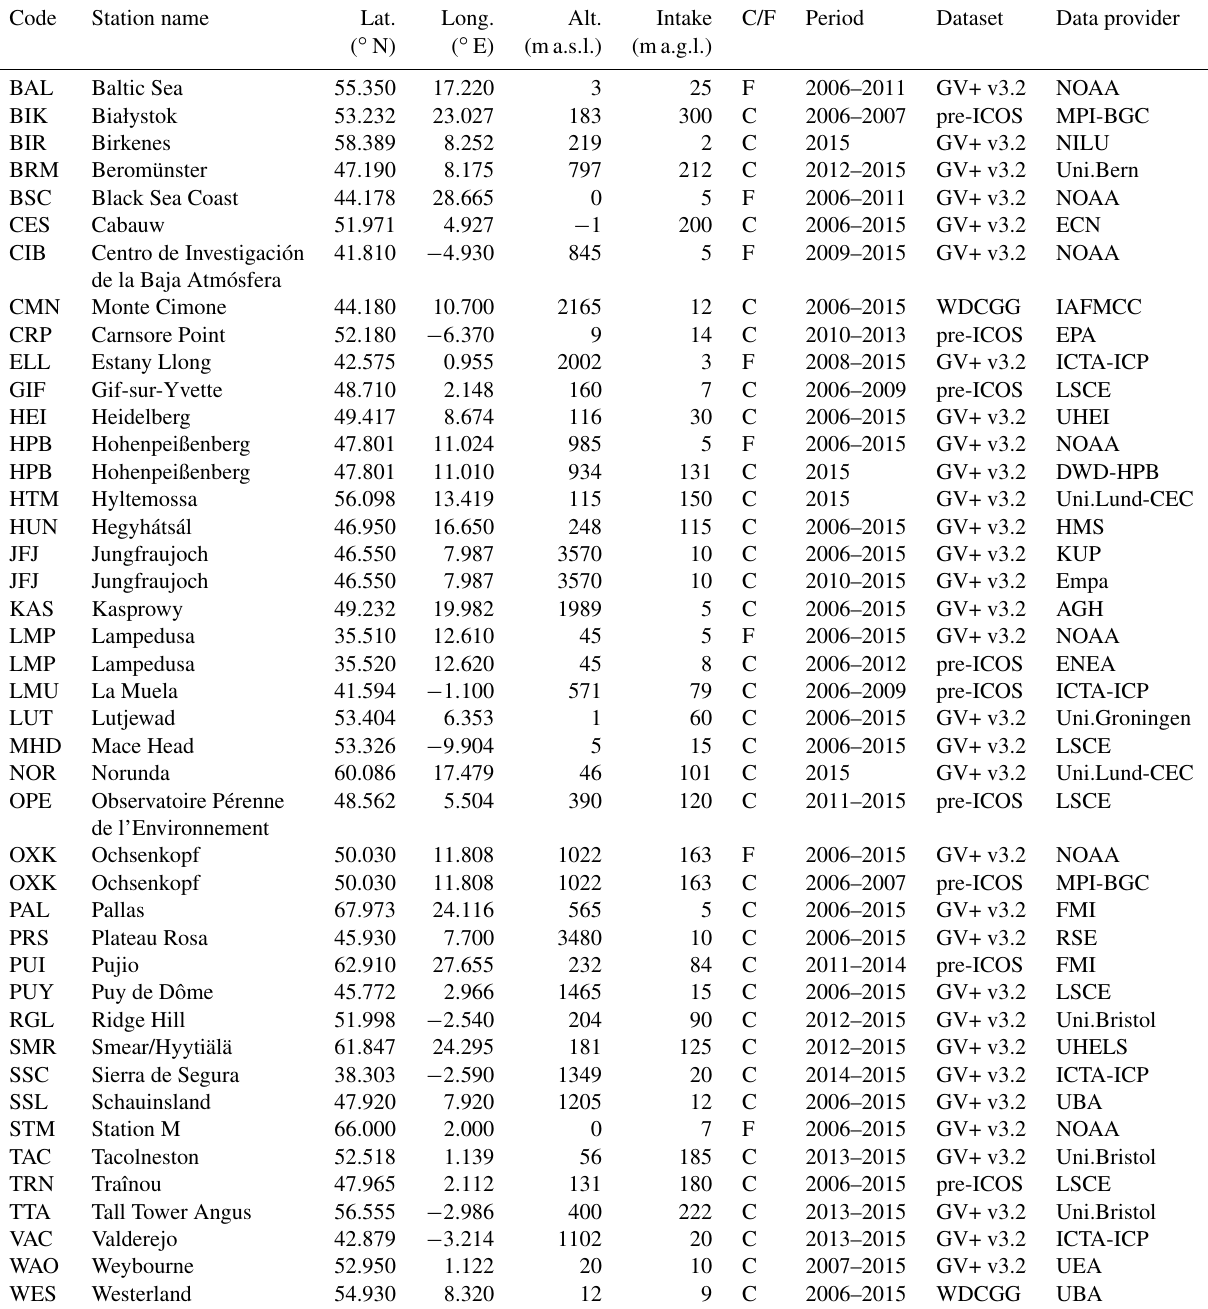
Table 1. Observation sites used in the inversions. Datasets with in situ continuous (C) as well as flask (F) measurements were taken from GLOBALVIEWplus ObsPack, WDCGG, and the EU-funded projects CarboEurope-IP, GHG-Europe and ICOS preparatory phase (all indi- cated as